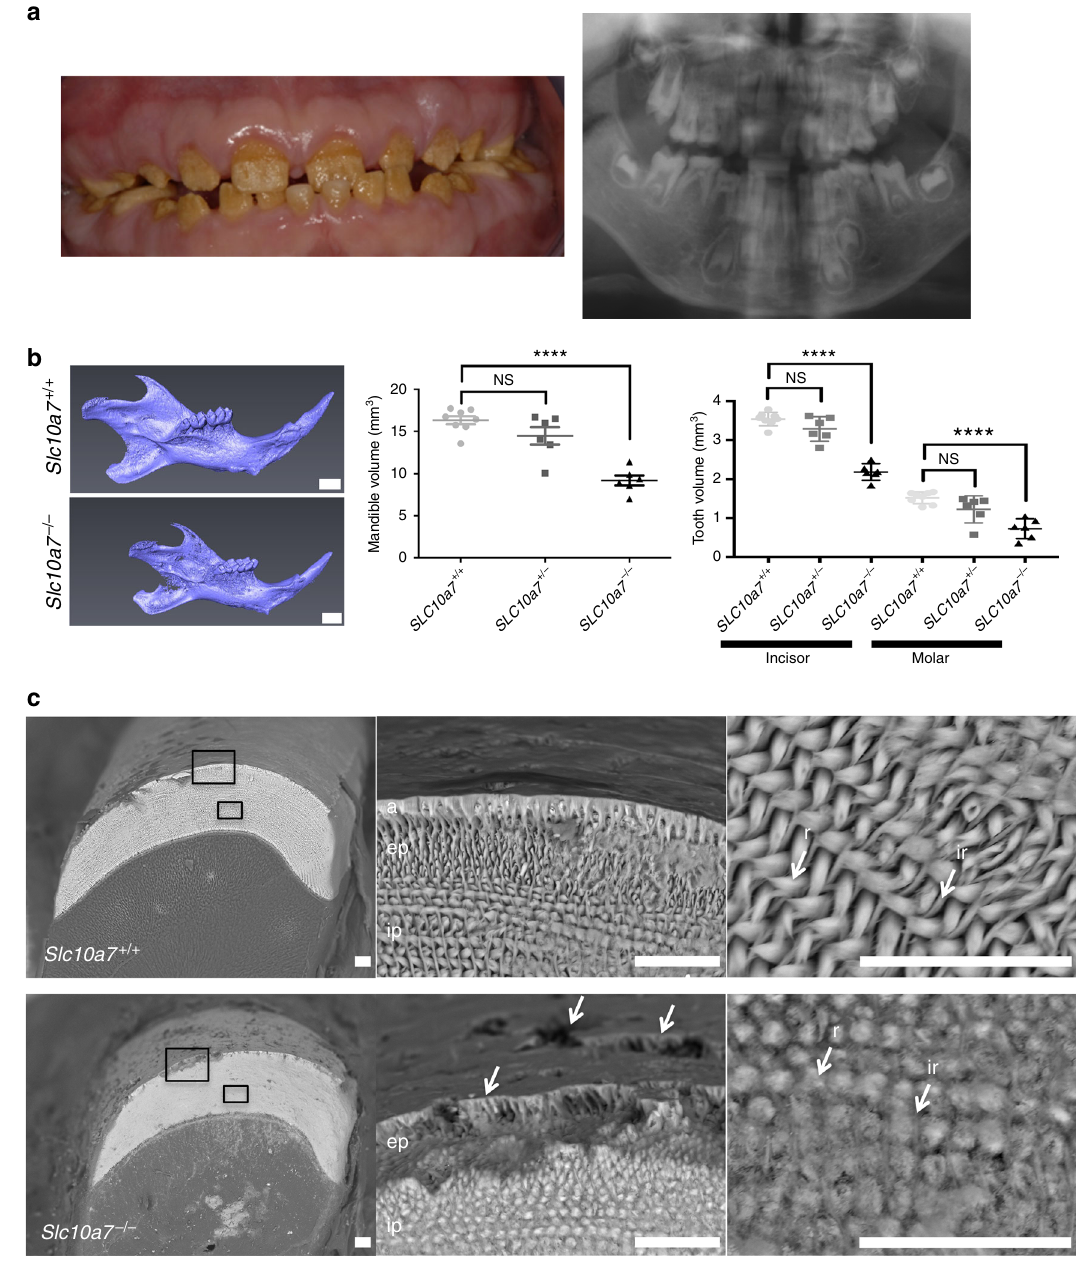
Fig. 4 SLC10A7 de fi ciency leads to enamel anomalies in human and in mice. a Intra-oral photography of Patient 4 at 9 years of age showing hypomineralized amelogenesis imperfecta (left panel). X-ray panoramic of Patient 5 at 6 years of age showing absence of enamel radiolucency corresponding to amelogenesis imperfecta associated with severe oligodontia (right panel). b Three-dimensional reconstruction of mandibles from μ CT analysis of 8-week-old mouse skulls and volume measurement of mandibles, lower incisors and lower molars at 8 weeks. Scale bars = 1 mm. Data are expressed as mean ± SD. NS, nonsigni fi cant; **** p ≤ 0.0001 (two-tailed t- test). n = 7 ( Slc10a7 + / + ), n = 7 ( Slc10a7 + / − ) and n = 6 ( Slc10a7 − / − ). c Scanning electron microscopy of mandible incisor from Slc10a7 + / + and Slc10a7 − / − mice. Low magni fi cation (left panels) shows conservation of enamel morphology but decreased thickness in Slc10a7 − / − mice. The boxed areas in the left panels are shown at higher magni fi cation (middle and right panels). In Slc10a7 − / − mouse enamel, the aprismatic layer was absent and the external prismatic layer was altered giving a rough aspect to the enamel surface (middle panels: arrows indicate hole in the external prismatic layer; a = aprismatic enamel layer, ep = external prismatic layer, ip = internal prismatic layer). High magni fi cation of internal prismatic enamel shows absence of a well-de fi ned prismatic pattern in Slc10a7 − / − mice, with fused rods and inter-rod structures (right panels; r = rod, ir = inter-rod). Scale bars = 20 μ m. These images represent three incisors